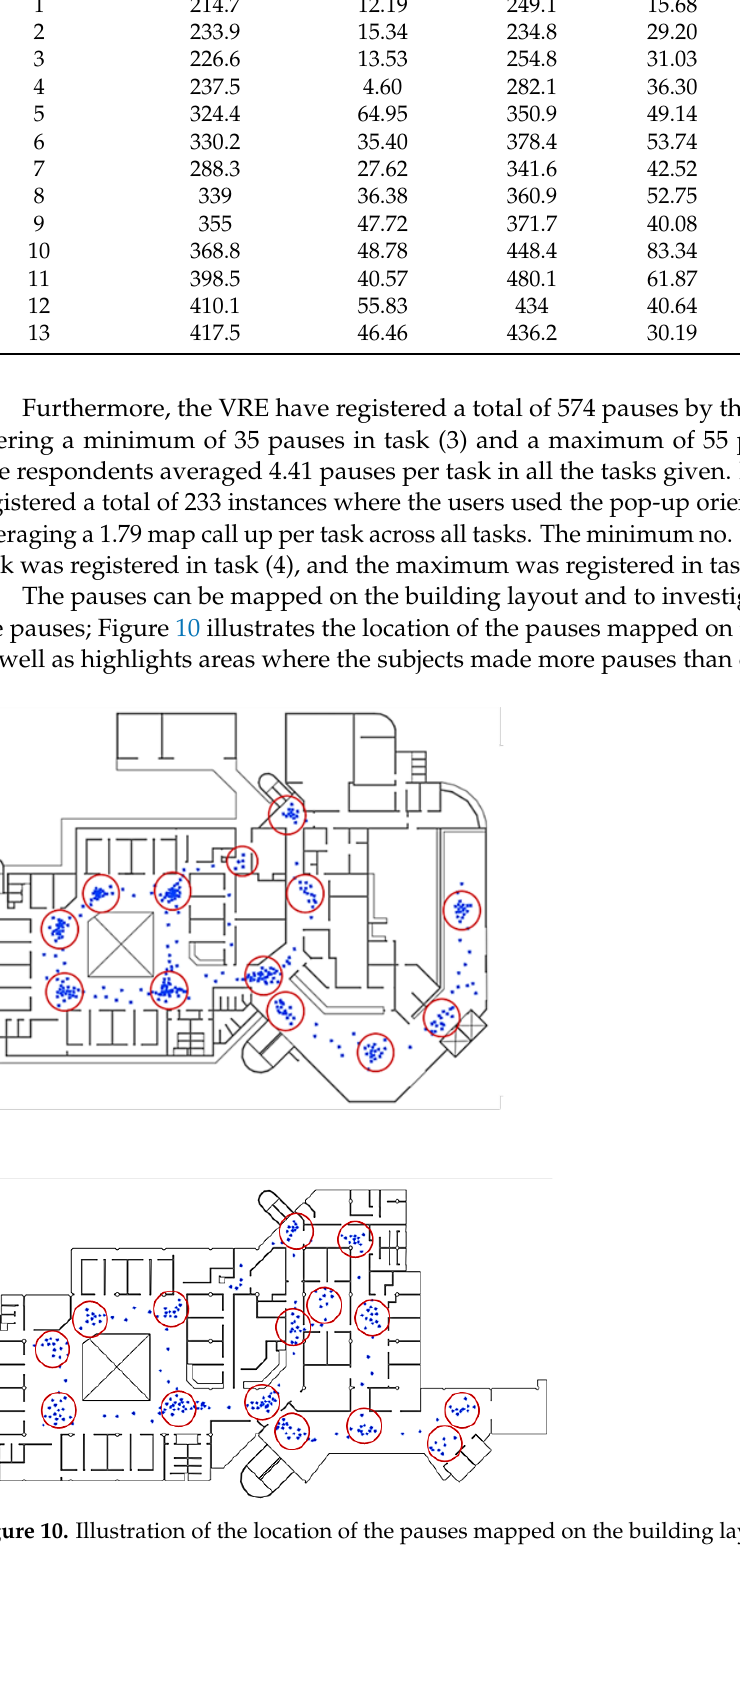
Average Time Stdv. (Seconds)